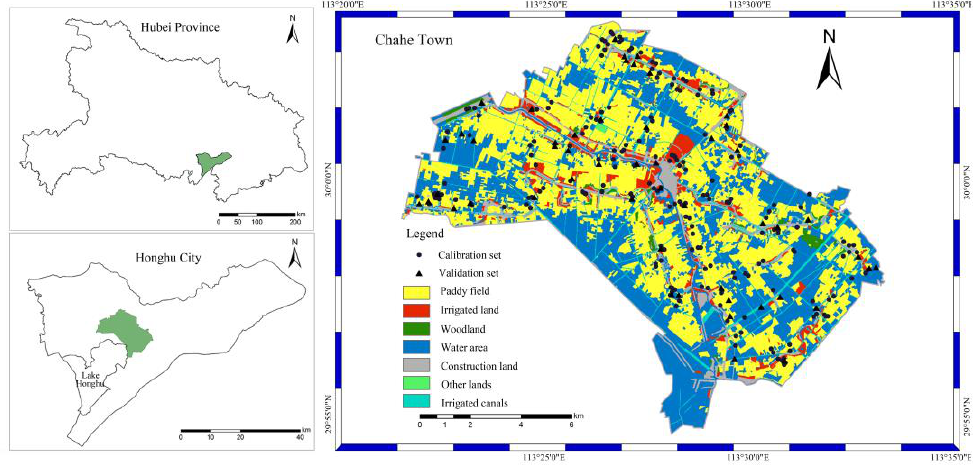
Figure 1. Study area and spatial distribution of soil